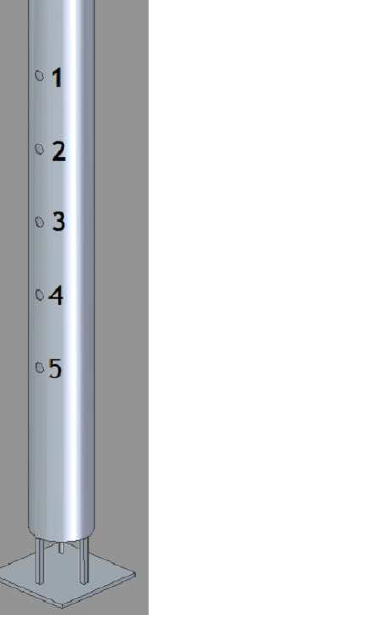
Figure 3. Measurement points located on the torch.